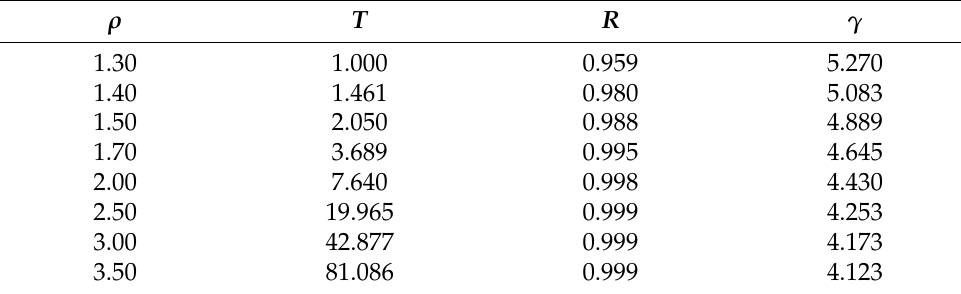
Table A4. Selected NiY 2 mixture state points of the isomorph (Figures